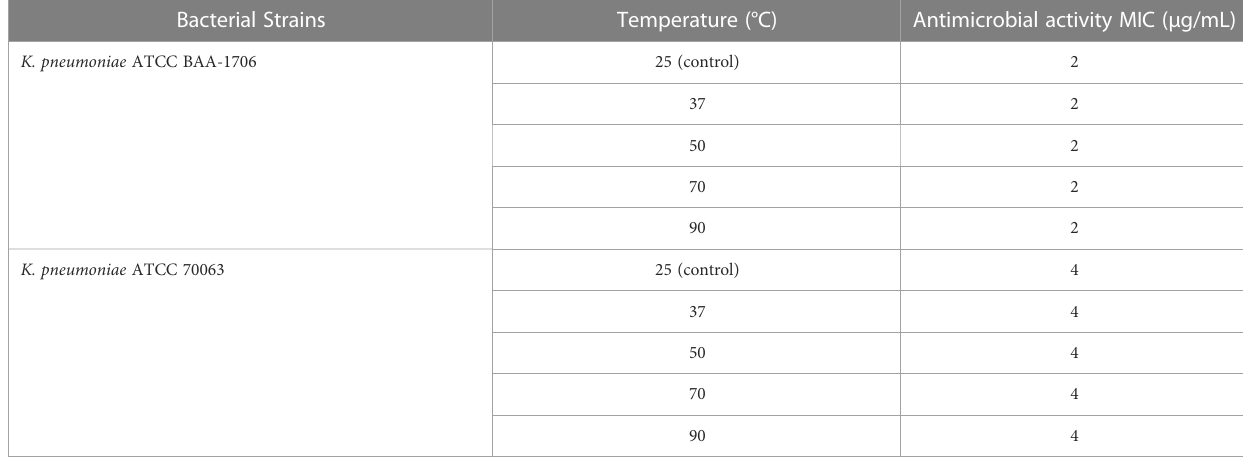
TABLE 3 The MIC values of the K11 against K. pneumoniae reference strains after different temperature treatments. Bacterial Strains